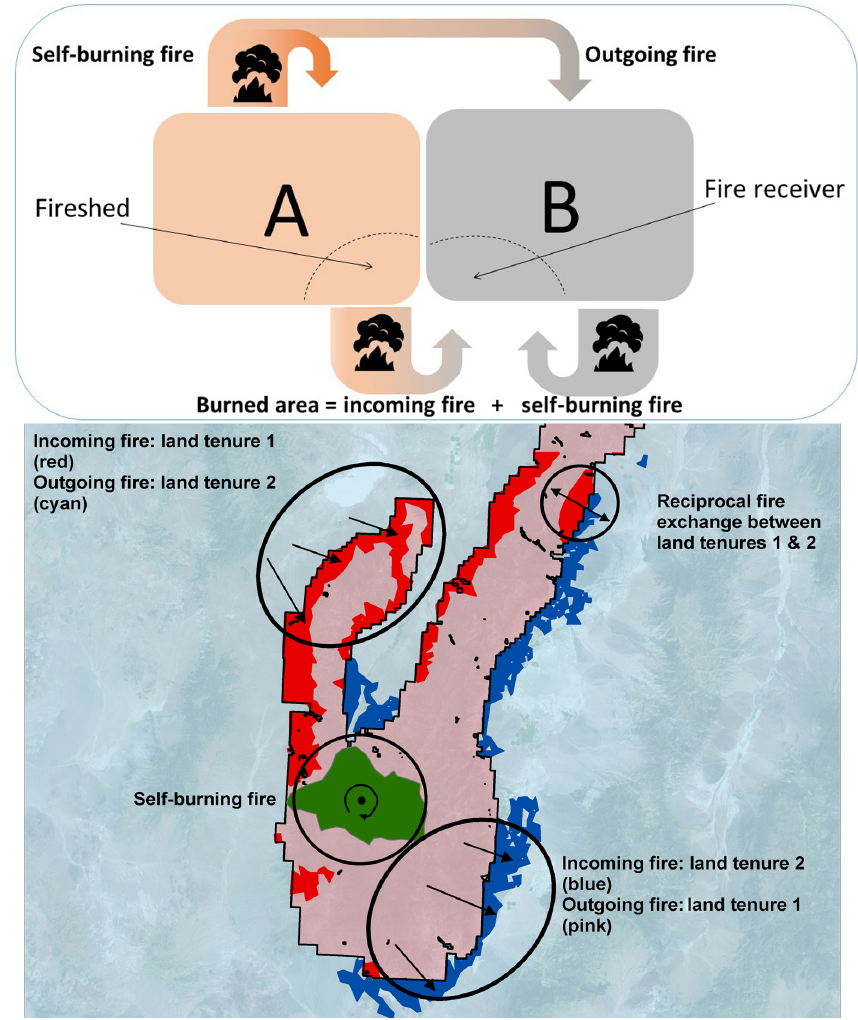
Figure 1. Conceptual map showing the cross-boundary fire exchange (incoming, outgoing, self-burning) between two land